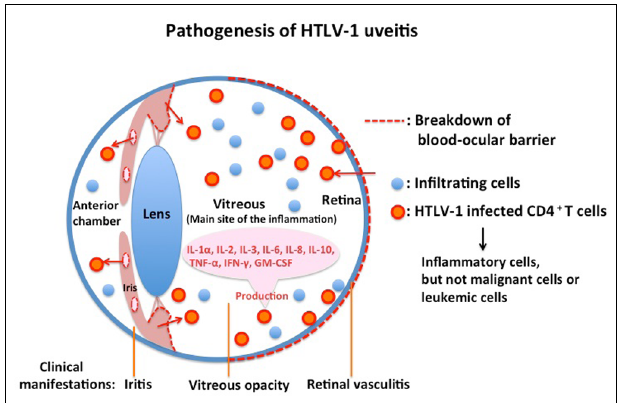
FIGURE 2 |The majority of infiltrating cells in eyes with HTLV-1 uveitis are inflammatory cells and not malignant or leukemic cells.